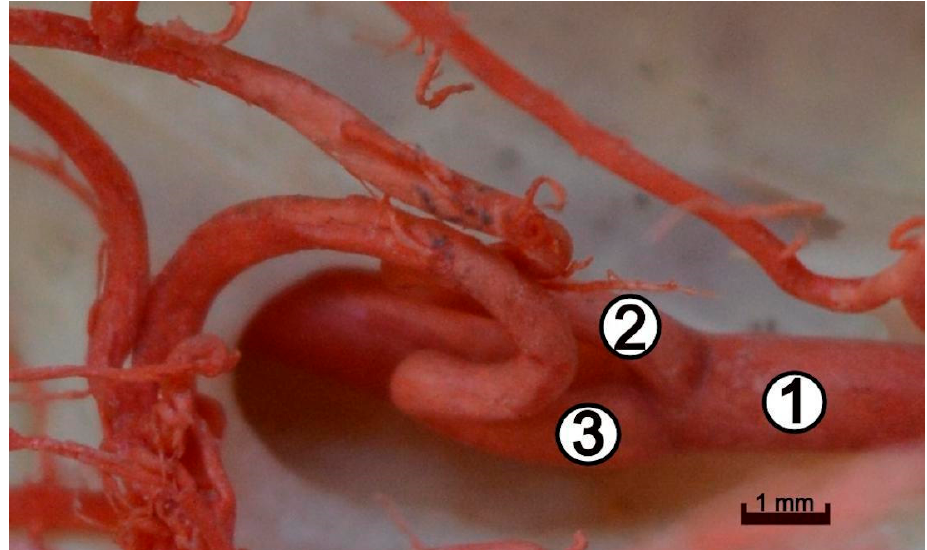
Figure 5. The left side of the caudal part of the arterial circle of the brain. Branches of the internal carotid artery, close up. Independent branching of the caudal cerebral artery and caudal communi- cating artery from the internal carotid artery. Corrosion cast. 1—internal carotid artery; 2—caudal cerebral artery; 3—caudal communicating artery. In 20 specimens, these vessels were found to branch off with a common trunk. The caudal cerebral artery is relatively weak, and supplies a small, caudally located area of the brain. From the caudal communicating arteries branched off the rostral cerebellar artery ( arteria cerebelli rostralis ) (Figure 4), supplying the anterolateral part of the cerebellum. Near the middle of the length of the basilar artery, the caudal cerebellar artery ( arteria cerebelli caudalis ) branched off. This vessel supplies the caudal part of the cerebellum. In addition, small arteries leading to the medulla oblongata were observed to branch off from the basilar artery. The basilar artery is an odd vessel with the same diameter over its entire length (Figure 6), and caudally joins the vertebral arteries ( arteriae vertebrales ).